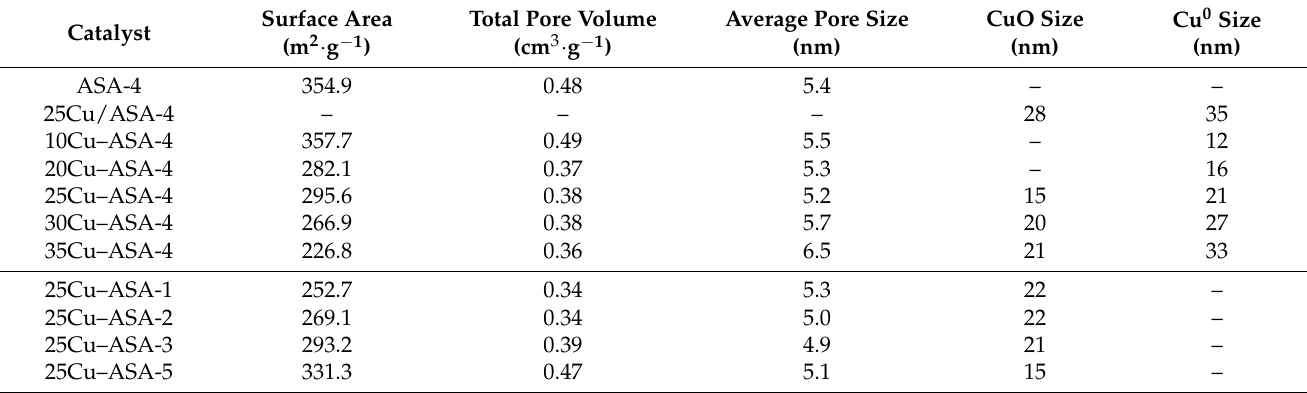
Table 1. Summary of the textural properties and the particle size determined by XRD for x Cu–ASA- y catalysts.